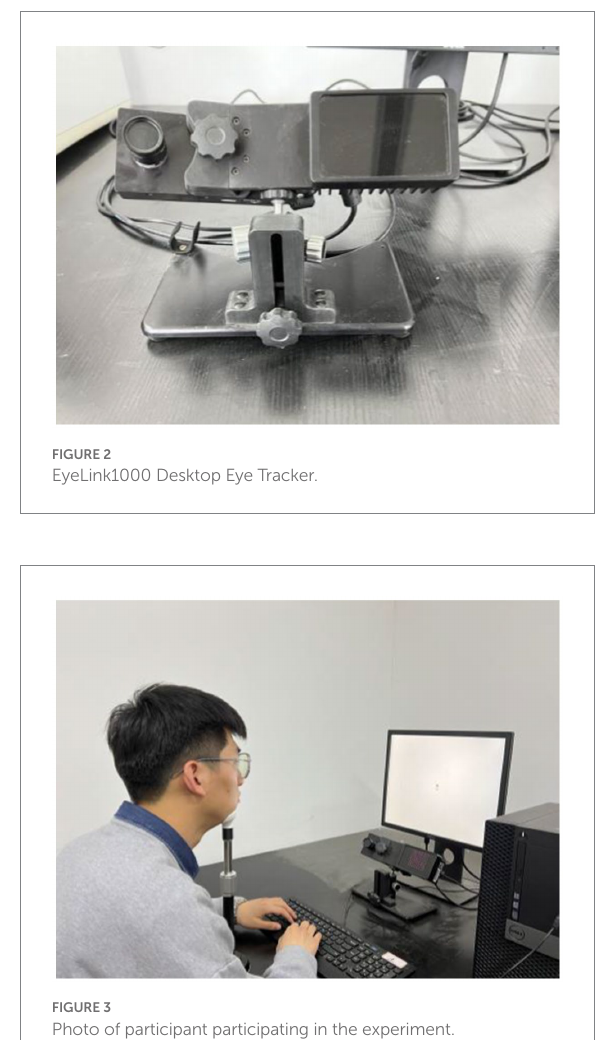
Figure 1C is the three-color combination randomly distributed icon interface G1 (in this experiment, the existing mobile map navigation icon interface), Figure 1D is the 1 × 5 layout icon interface G2, Figure 1E is the 3 × 5 layout icon interface G3.